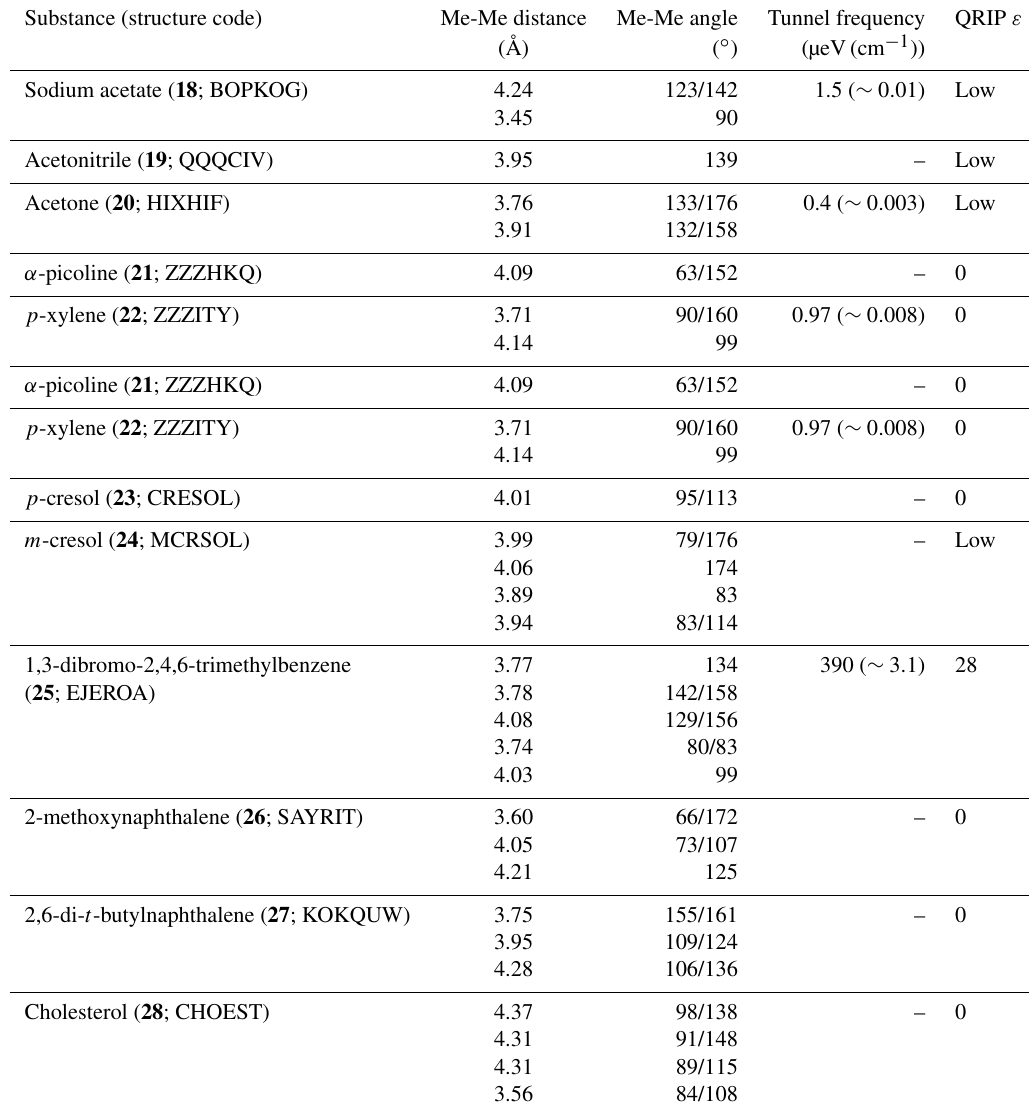
Table 6. List of compounds tested for QRIP in Icker et al. (2013) and Icker (2013). Methyl-methyl distances (measured carbon to carbon) and angles between methyl groups (measured along the path from quaternary carbon via methyl carbon to the methyl carbon of the neighbor molecule) were taken from the crystal structure data. Tunnel frequencies were taken from Prager and Heidemann (1997). In addition to the name of the substance, the crystal structure code is given in